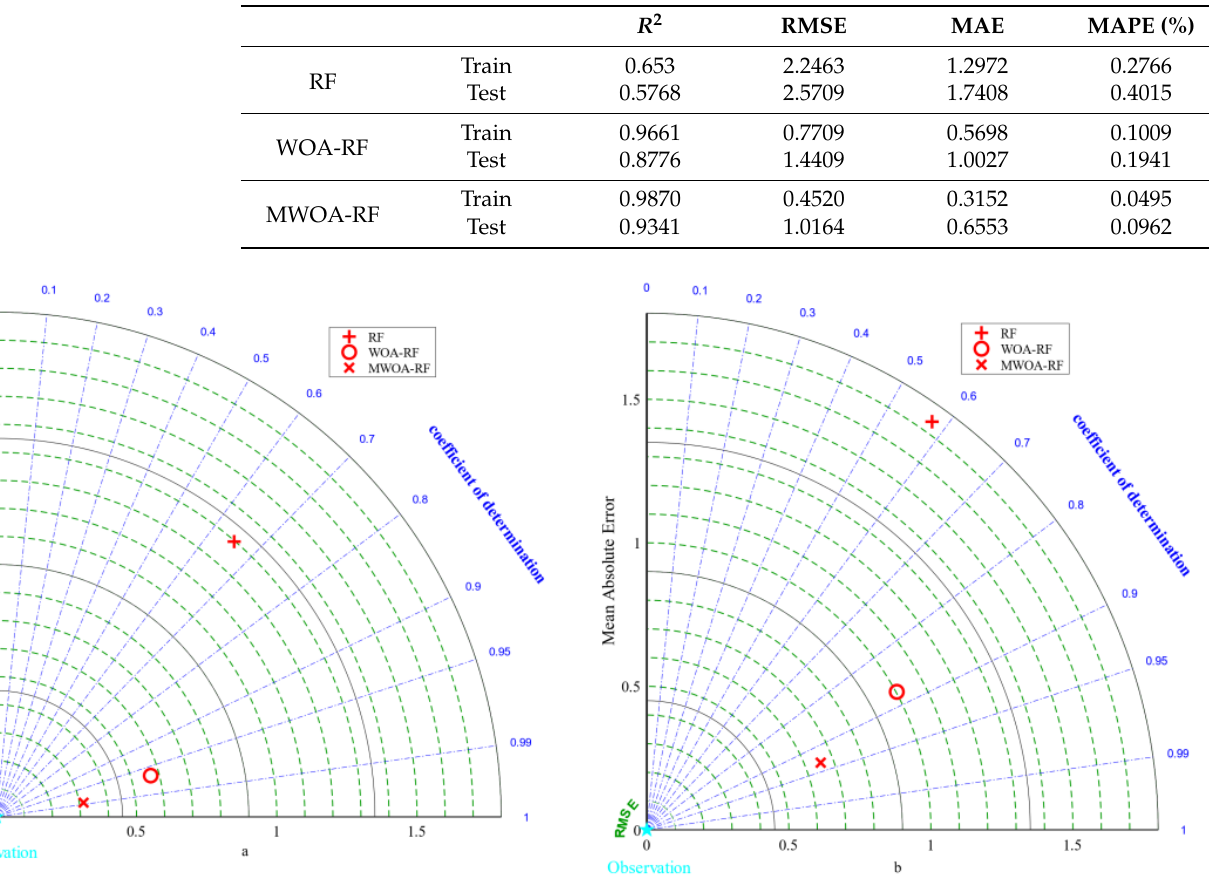
Figure 9. Taylor diagrams for the Training ( a ) and Testing ( b ) sets of the three RF models. Table 5. Average of evaluation indicators for three RF models.